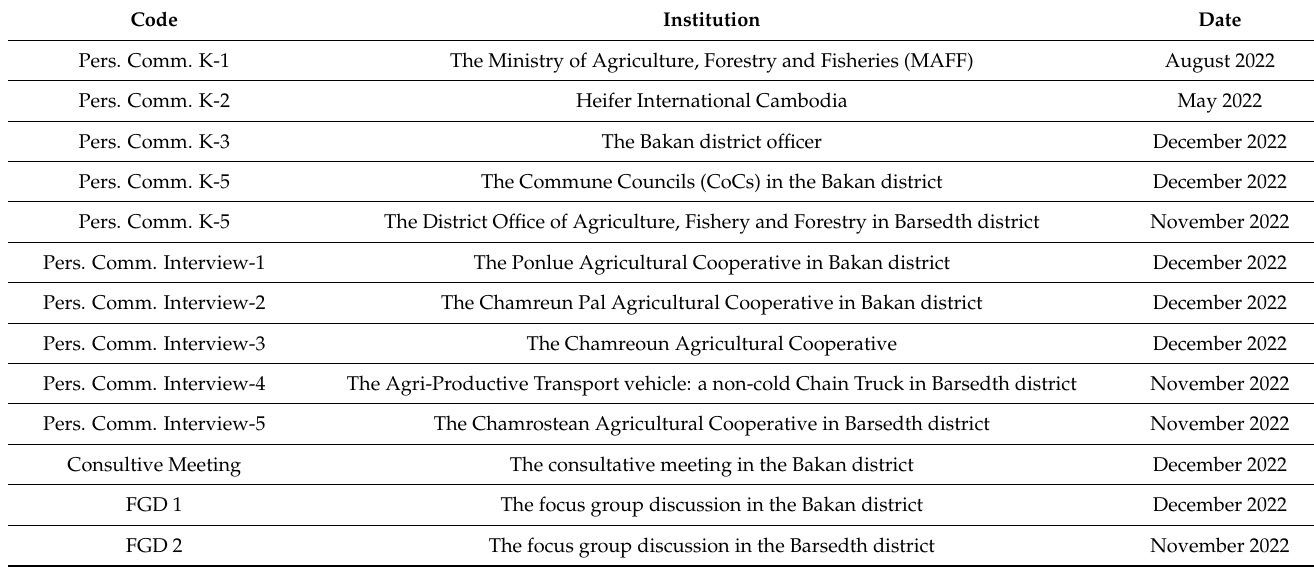
Table A2. List of Participants for Key Informants and In-depth